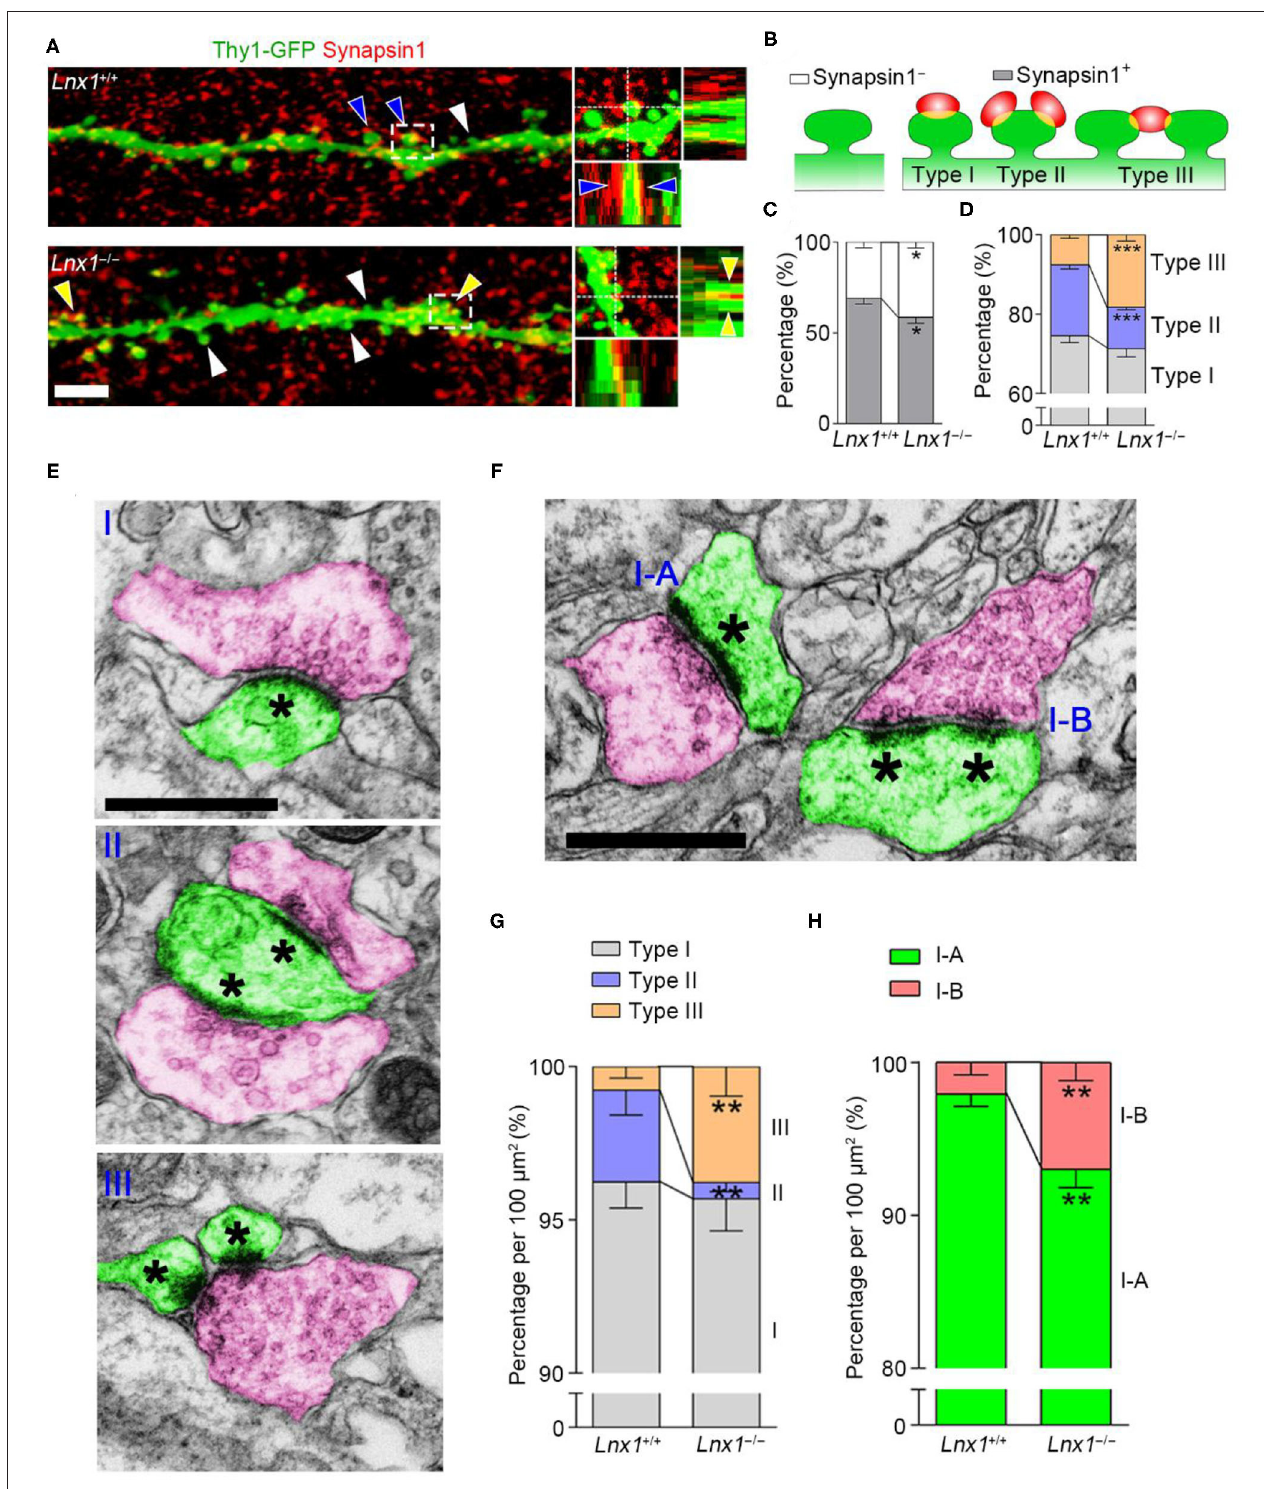
FIGURE 2 | Ligand of Numb protein X 1 (Lnx1) is required for synapse formation in CA3 neuron. (A) Representative images showing the deconvolved 3D-rendered views of spines of CA3 neuron (green) contacting synapsin1 (red) in PW3 WT and Lnx1 − / − mice (left). Cross-sections through the x- and y-axes show the interface between the spines and synapsin1 + terminals (right). White arrowheads indicate synapsin1 − spine, blue arrowheads indicate type II synapse, yellow arrowheads indicate type III synapse. Scale bar represents 4 µ m. (B) Schematic diagram showing synapsin1 − spine and synapsin1 + spines which include three types of